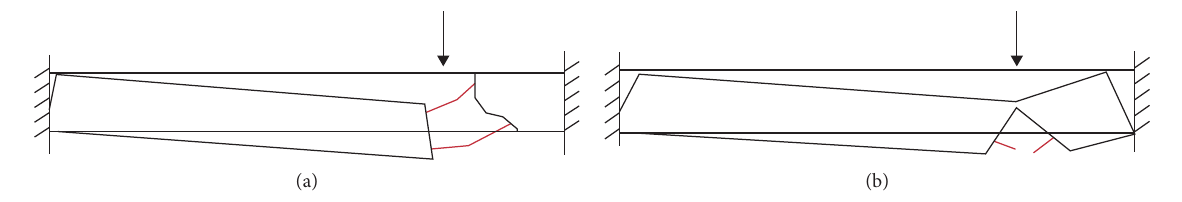
Figure 8: Different failure modes of specimens. (a) Unstrengthened specimen (FH2). (b) Strengthened specimen (FH2-H1).